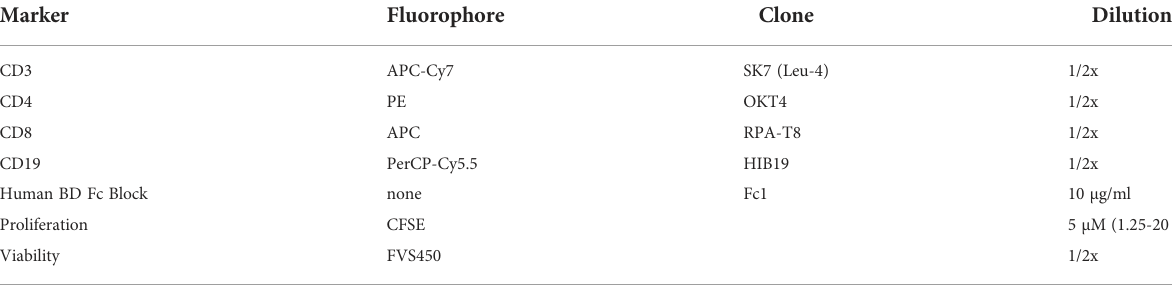
TABLE 1 Detailed list of reagents and concentrations applied for fl ow cytometry. Marker